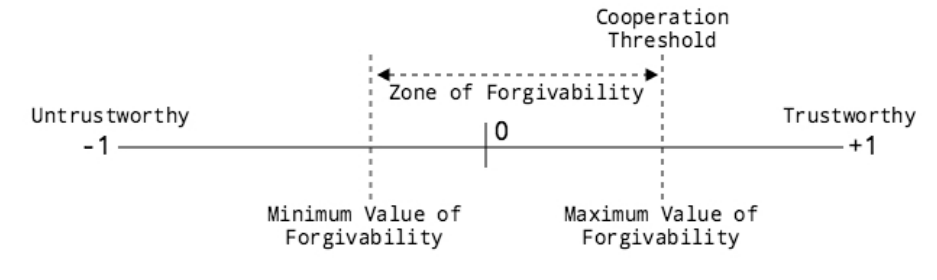
Figure 1. The Zone of